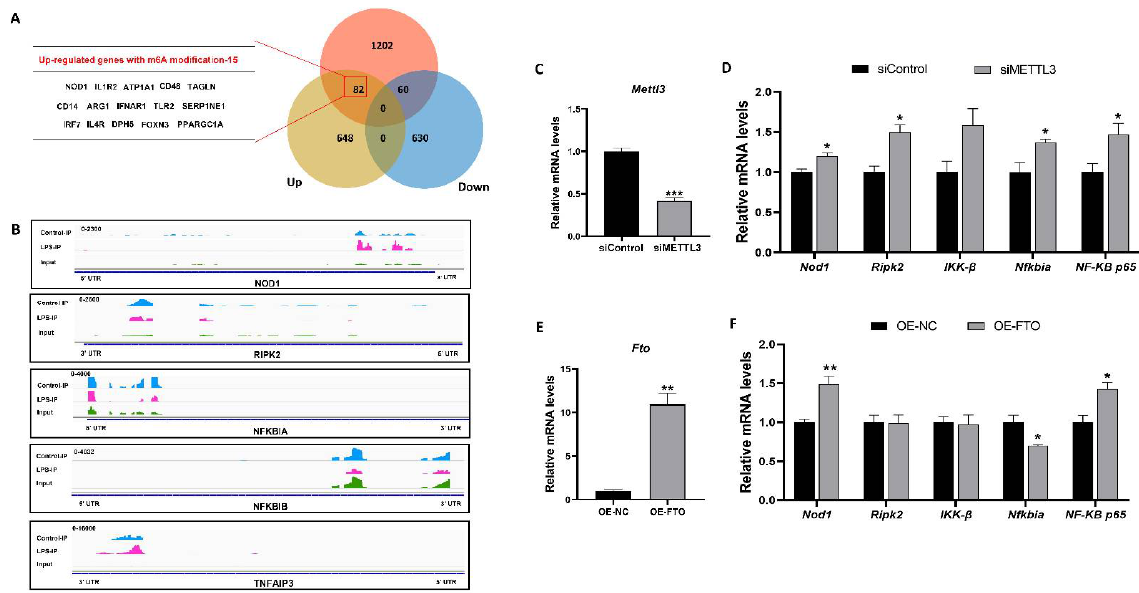
Figure 5. M 6 A RNA methylation modulated the NOD1/NF- κ B signaling pathway. ( A ) Venn diagram showed the relationship between m 6 A modification and mRNA expression by the combined analysis of RNA-seq and MeRIP-seq. ( B ) The m 6 A peak profile on NOD1, RIPK2, NFKBIA, NFKBIB, and TNFAIP3 mRNAs were examined by IGV. Wathet blue, dark blue, and red patterning, respectively, represented m 6 A peaks on mRNA in the LPS, CON and input groups. ( C ) The METTL3 mRNA expression in the siControl and siMETTL3 groups. ( D ) Effect of the knockdown of METTL3 on key genes of the NOD1/NF-κB signaling pathway in HepG2 cells. ( E ) The FTO mRNA expression in the OE-NC and OE-FTO groups. ( F ) Effect of the overexpression of FTO on key genes of the NOD1/NF- κ B signaling pathway in HepG2 cells. Results are showed as means with SEM represented by a vertical bar (n = 3). * represents significant differences between the CON group and the LPS group;